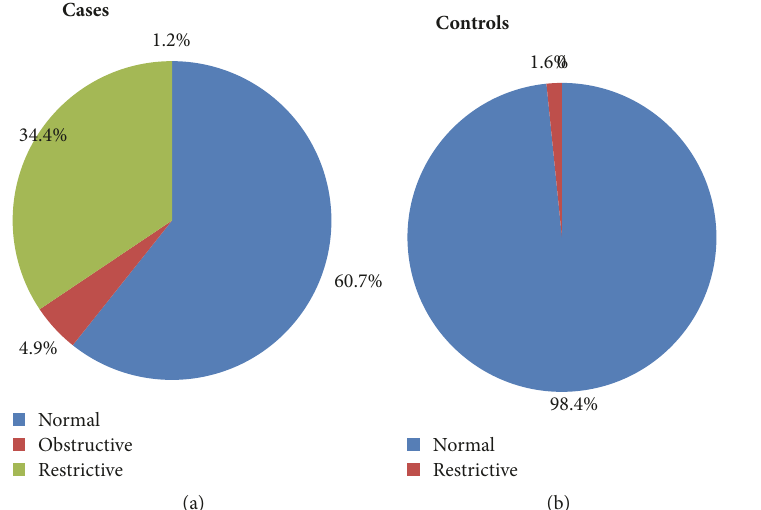
Figure 4: Pulmonary function status in hypertensive patients (a) and nonhypertensive persons (b) at Zewditu Memorial Hospital, Addis Ababa, Ethiopia,